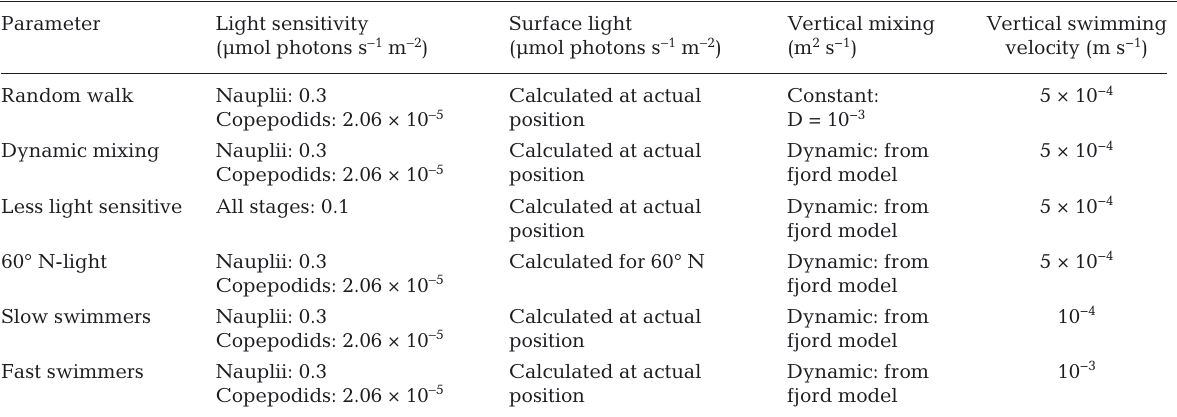
Table 1. Parameter settings used for triggering vertical swimming during the salmon lice Lepeophtheirus salmonis